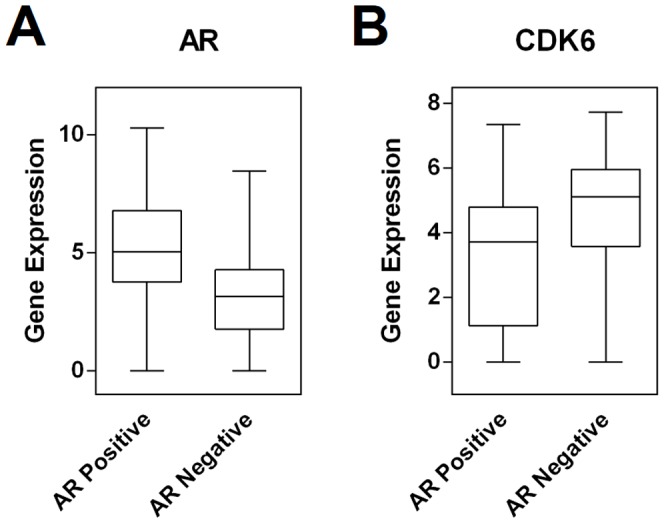
Androgen receptor expression status defines novel potential therapeutic targets.mRNA expression profiling of 160 TNBC cases was dichotomized according to their AR immunohistochemical status (AR negative vs AR positive). As expected, AR mRNA was significantly up-regulated in AR-positive cases (logFC 2.33; p<0.01; A). Among the deregulated mRNAs, CDK6 showed significantly higher expression in AR-negative cases (logFC -1.16; p<0.01; B).